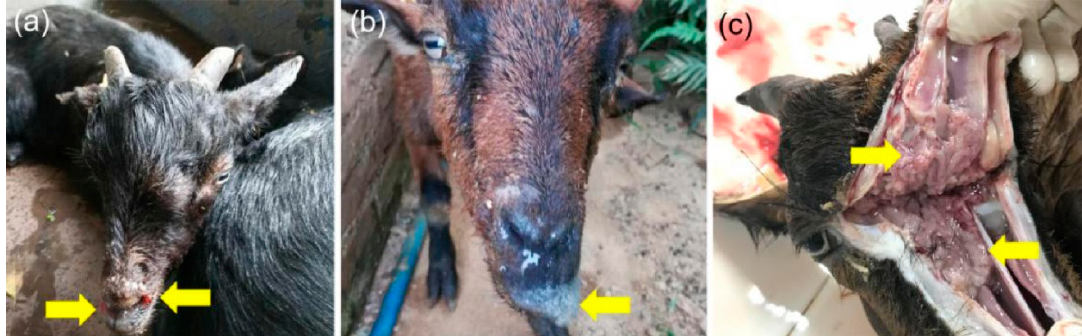
Figure 1. Clinical manifestations and pathological changes of goats affected by enzootic nasal tumor virus (ENTV)-2. ( a ) Bloody polyps appeared around the nostrils of a goat’s nose (Goat 1, about 3-month-old). ( b ) A lot of nasal discharge appeared around the nose (Goat 2, about 10-month-old). ( c ) The nasal cavity (Goat 3, about one-year-old) filled with tumor-like tissues.